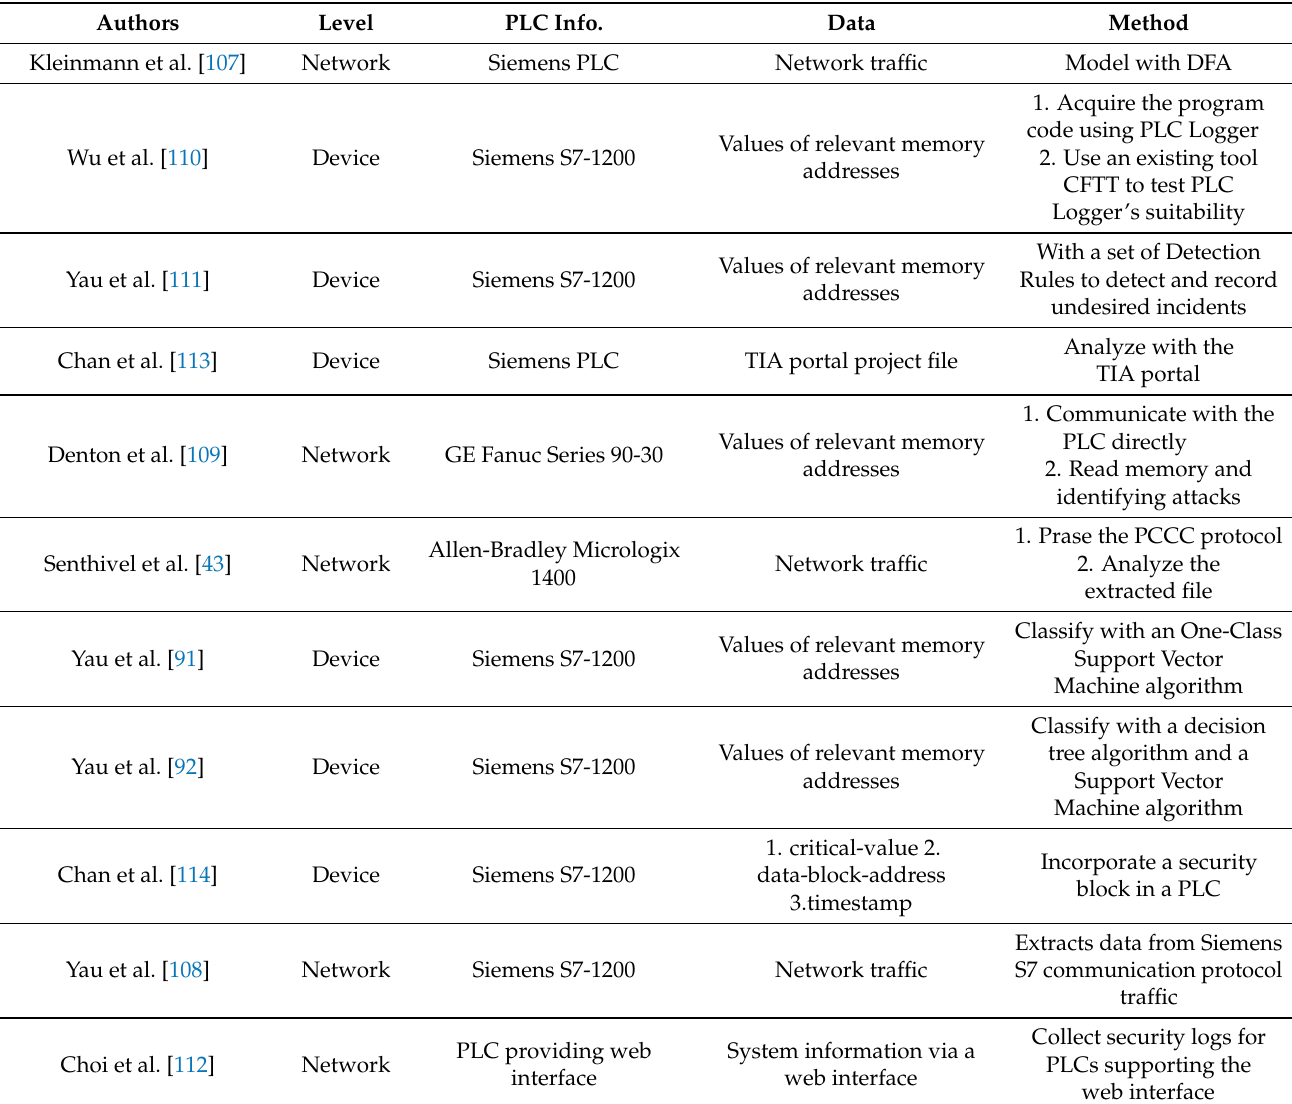
Table A3. Focus on digital forensics for the PLC-based control